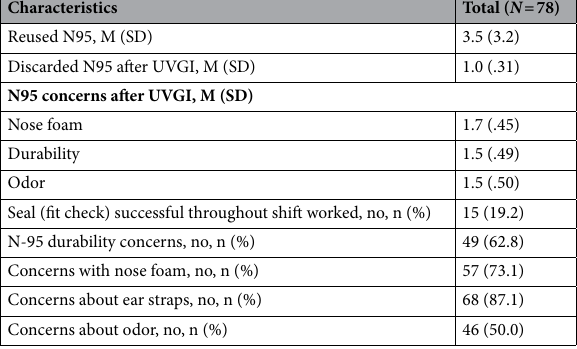
Table 3. UVGI survey